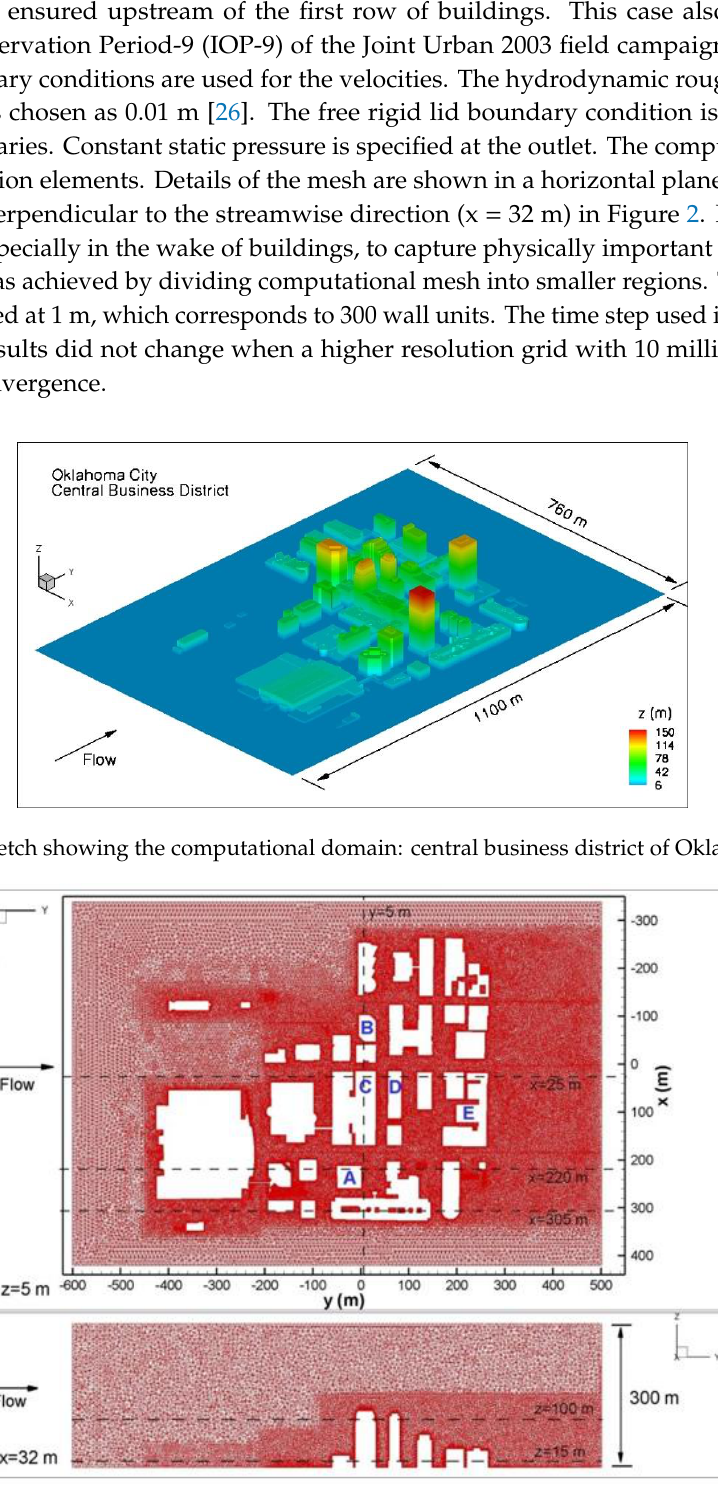
Figure 2. Computational mesh ( a ) in a horizontal plane, z = 5 m; ( b ) in a vertical plane, x = 32 m. Dashed lines show the location of x- and z- sections used in the analysis.